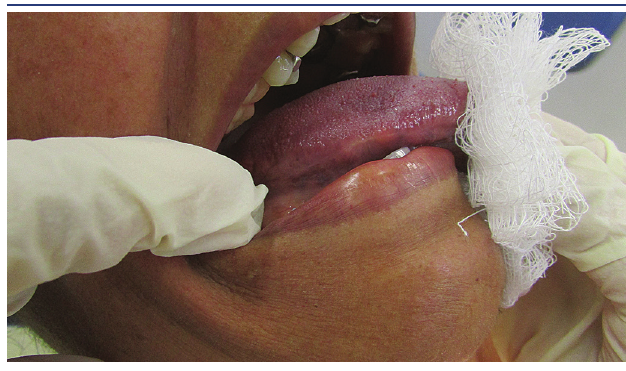
figurE 1 − Clinical features of the intraoral aspect of the lesion A) vascular lesion on the right lateral border of the tongue; B) swelling exhibiting significant necrosis associated with purulent discharge seven days after injection of Ethamolin ® ; C) clinical aspect after debridement of the infected area; D) complete regression of the lesion 21 days after sclerotherapy.